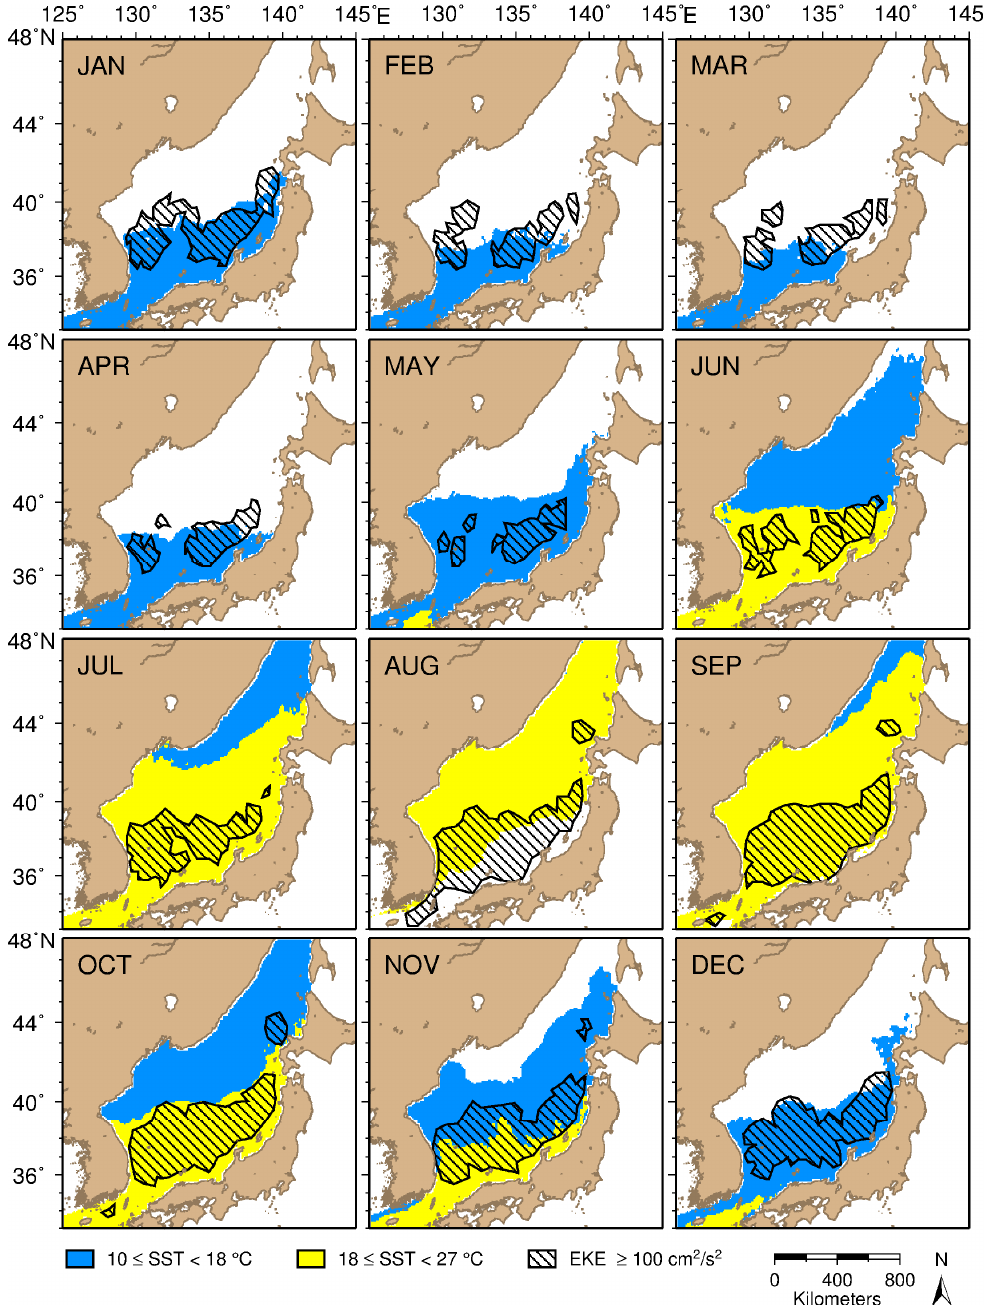
Figure 6. Monthly maps of favorable SST (10 °C–27 °C) characterizing the squid habitat from January–December, 2010–2013. The SST range was divided into the colder (blue) and warmer (yellow) bins. The black polygons correspond to areas with moderate to high EKE values.